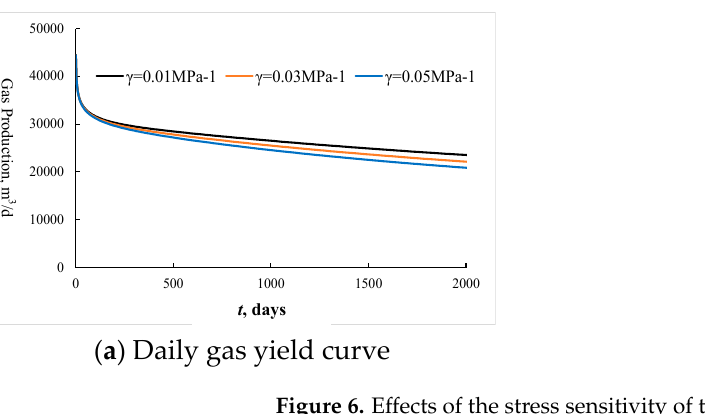
be seen that the smaller the distance from the outer boundary, the lower the position of the gas and